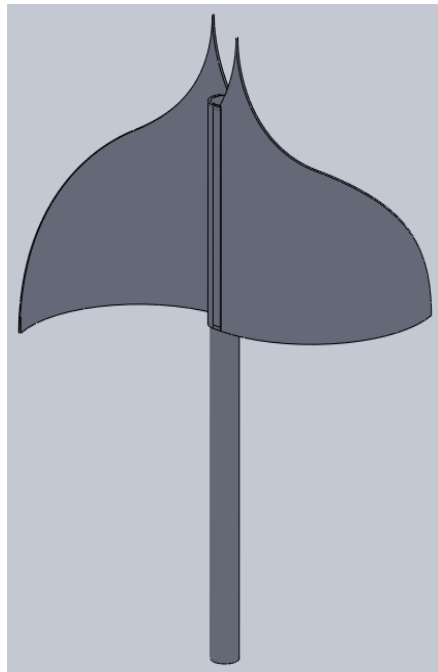
Figure 6. IceWind turbine. Figure 6. IceWind